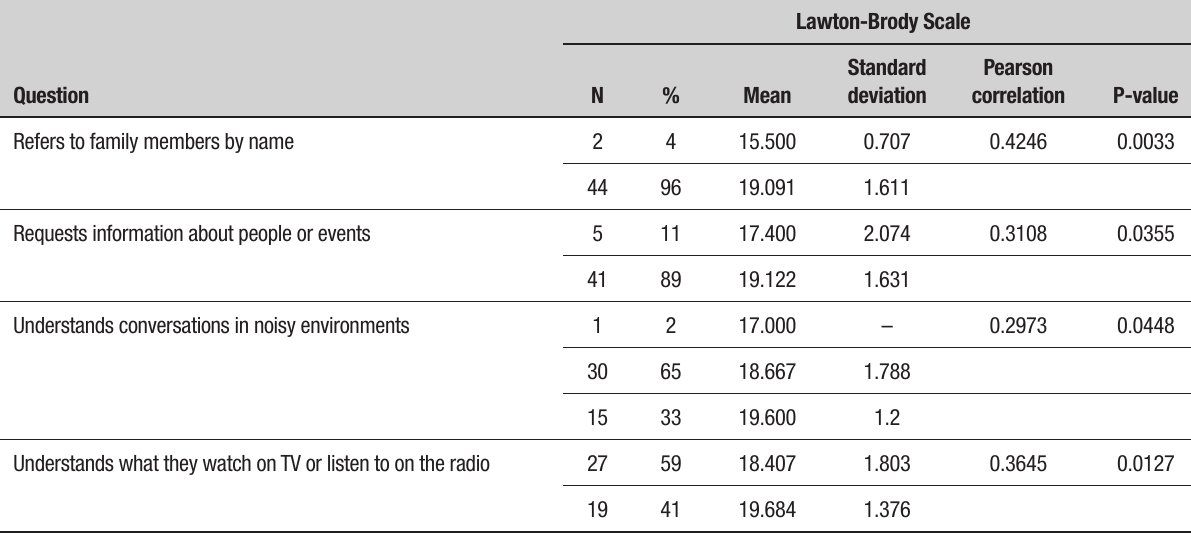
Table 2. Relationship between social communication components of the ASHA FACS scale and performance on Lawton-Brody